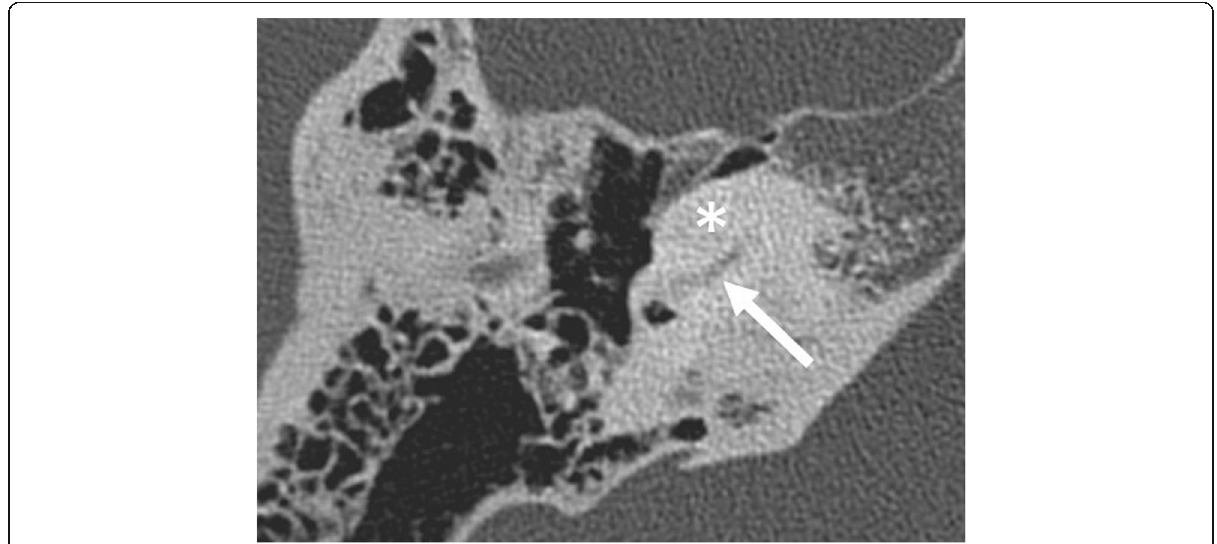
Fig. 5 A 38-year-old female patient, with unilateral sensorineural deafness since the age of 12 years. HRCT axial image shows cochlear sclerosis (asterisk). Only a small part of the basal turn of the cochlea can be faintly seen